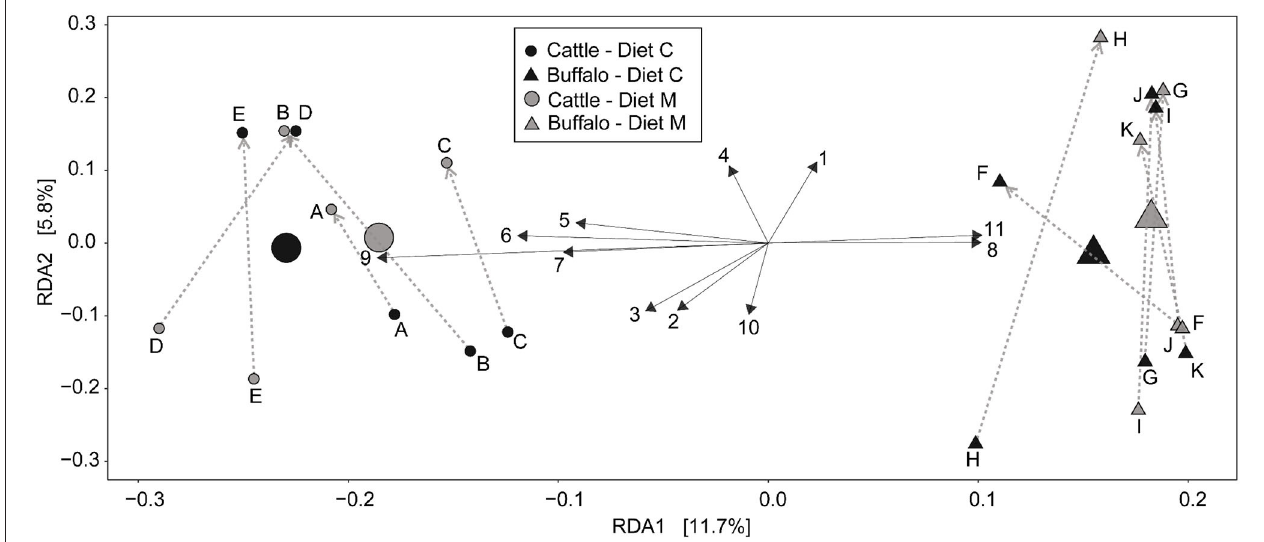
FIGURE 2 | Redundancy analysis biplot of the rumen prokaryotic communities at the level of individual ASVs. constrained by host type (cattle or buffalo) and experimental period. Small symbols are data points represent of rumen microbial communities of individual samples and are labeled with the respective animal codes for the Holstein-Friesian cattle (A–E) and Mediterranean buffalo (animals F–K ). Large symbols indicate the weighted center of all samples from a group. The diets containing maize grains grown on soil that was treated (Diet M) or not (Diet C) with a commercial AMF preparation are also indicated. Gray dotted arrows indicate the direction of the cross-over from the first to the second experimental period. Black solid arrows depict the 11 ASV’s whose abundance most accurately fits the shown variation. The longer the arrow. the stronger the association with the samples in that direction. Due to space restrictions on the plot these arrows are numbered and the corresponding ASV identification number and taxonomic annotation is stated in this legend. Annotation is only given to the taxonomic level [i.e., phylum (p), class (c), order (o), family (f), or genus (g)] to which it can be reliably annotated. The ASV details are: [1] ASV 350279275 = f_Prevotellaceae.g_; [2] ASV 35027951 = g_Prevotellaceae_UCG-001; [3] ASV 35027962 = g_Prevotellaceae_NK3B31_group; [4] ASV 350279171 = g_Prevotella_1; [5] ASV 3502796 = g_Prevotella_1; [6] ASV 35027983 = p_Bacteroidetes.f_F082.g_; [7] ASV 3502793 = p_Bacteroidetes.f_F082.g_; [8] ASV 35027920 = p_Bacteroidetes.f_p-251-o5. g_uncultured _bacterium; [10] ASV 35027993 = g_Christensenellaceae_R-7_group; [11] ASV 350279543 =